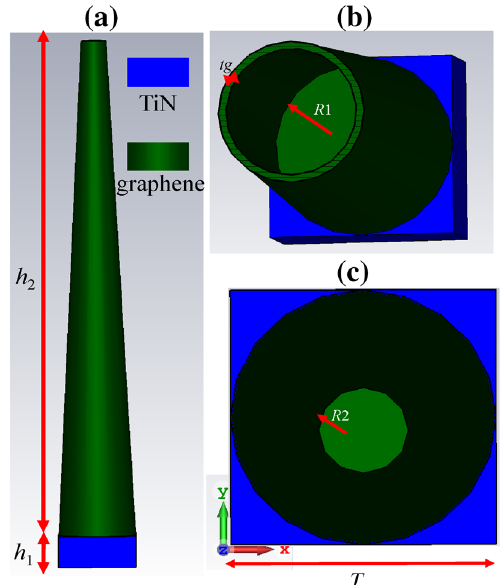
Figure 2. Unit cell of the proposed solar cell constructed by hollow graphene-based shell-shaped nano-pillars backed by a refractory metal ( a ) side view ( b ) top view for h 2 = 500 nm and ( c ) overall top view. The substrate and nano-pillar heights are respectively h 1 and h 2 . The thickness of the graphene shell is denoted by t g . Moreover, the bottom and top radii of the cone are R 1 and R 2 respectively. The periodicity of the nano-pillars in the square lattice is T .